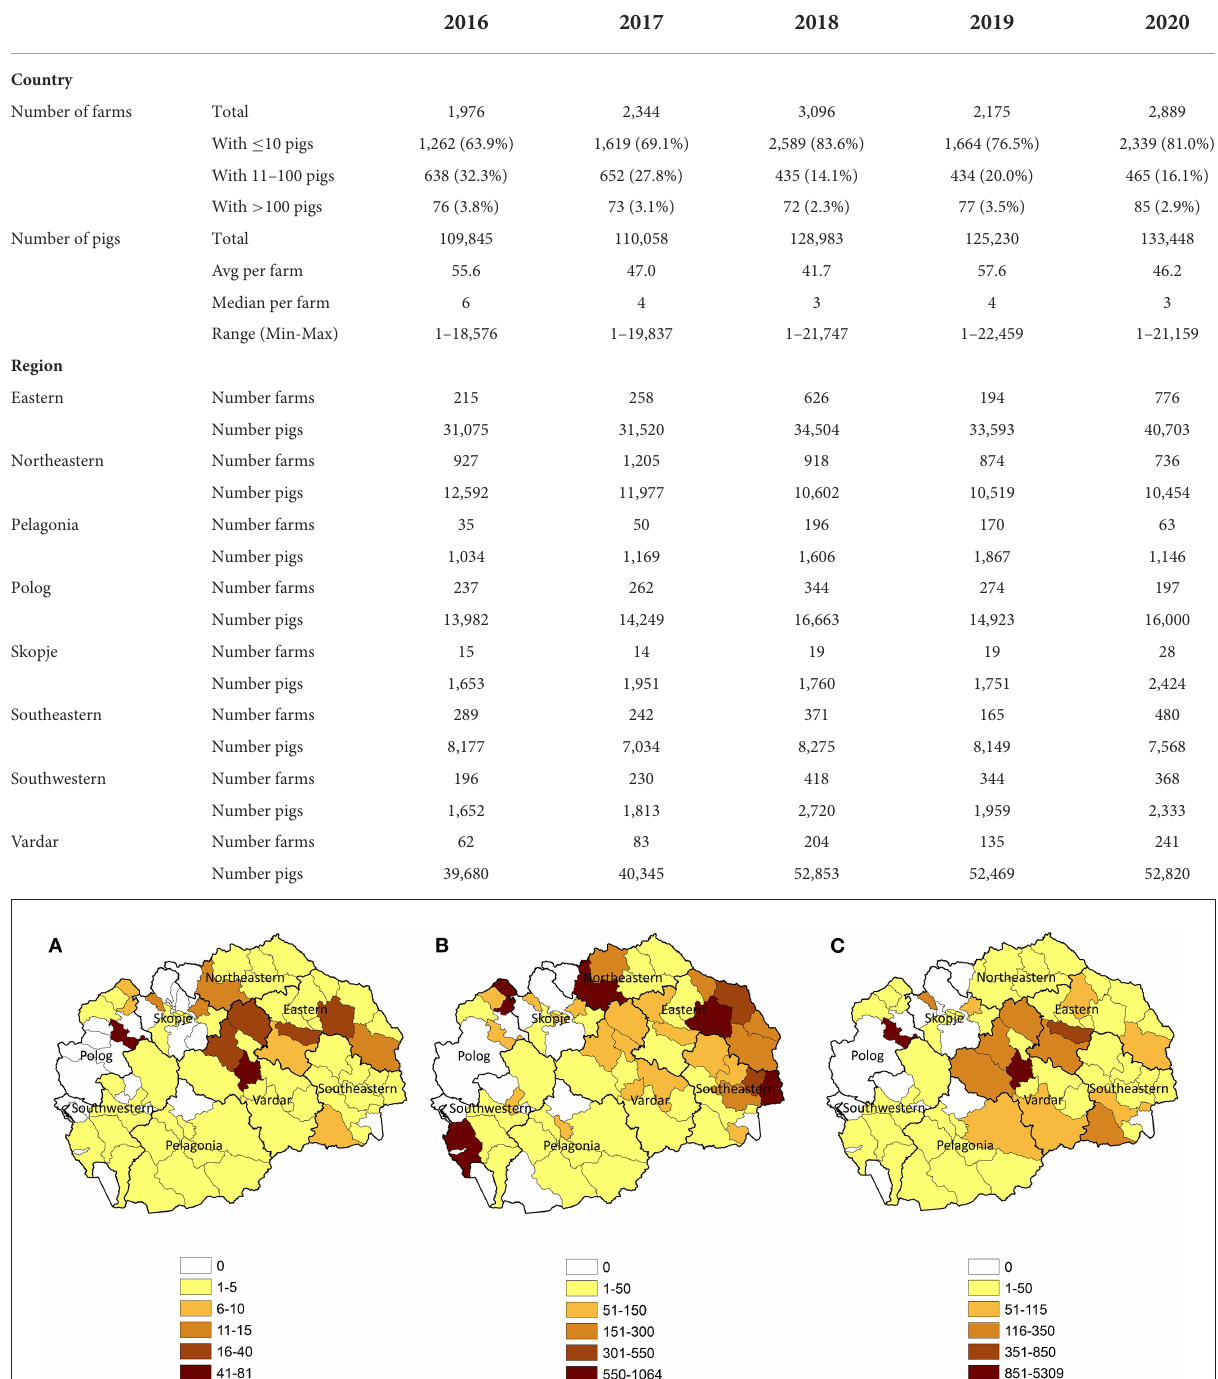
TABLE 1 North Macedonia pig census data 2016–2020 summarized on the country and regional level.